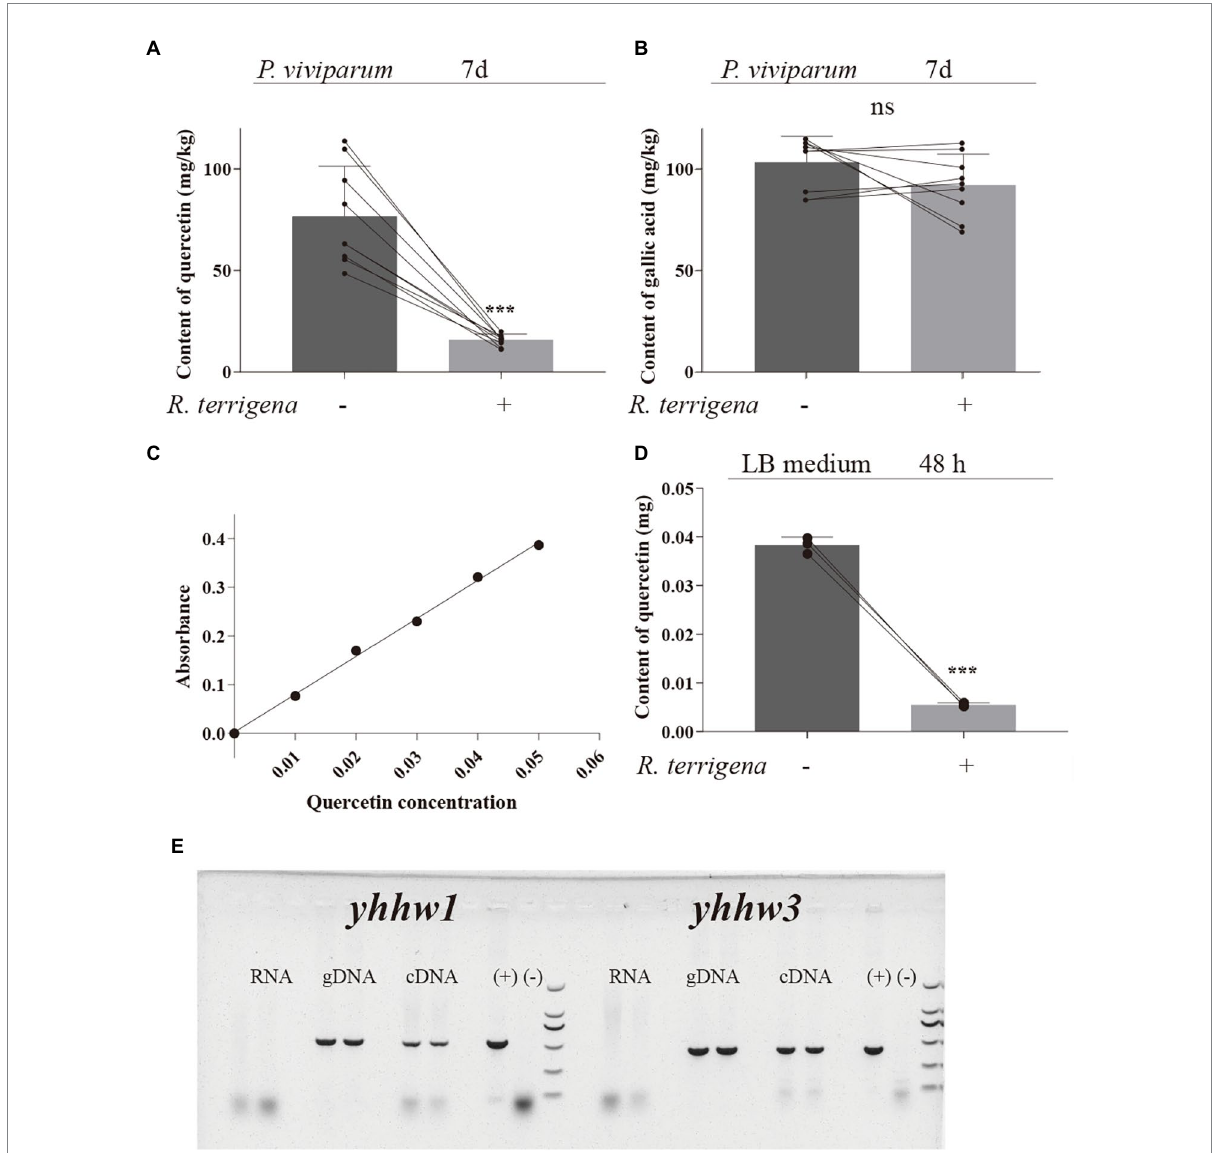
FIGURE 3 Quercetin degradation by R. terrigena in P. viviparum powder and in LB medium. Contents of quercetin (A) and gallic acid (B) analyzed by HPLC- DAD, in 25% P. viviparum root powder fermented with or without R. terrigena for 7 days, standard curve of quercetin added in the LB culture medium (C) and quercetin degradation in LB medium with or without R. terrigena cultured for 48 h (D) , expression of the genes yynw1 and yynw3 in natural larvae of T. xiaojinensis (E) . Electrophoresis of the products for the different templates used for RT-PCR of the genes yynw1 and yynw3 . No product was detected for the total RNA indicating the RNA without contamination of DNA. A band of ~500 bp for yynw1 and A band of ~400 bp for yynw3 were obtained for both cDNA and DNA. (+) positive control, DNA product from R. terrigena . ( − ) non-template